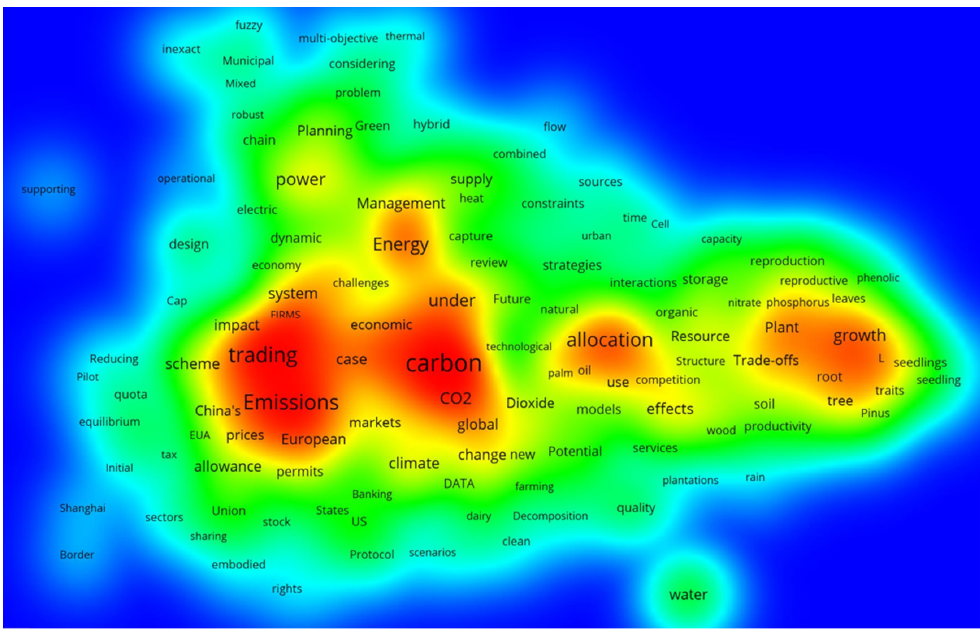
Figure 7. Words that appear more than ten times in the abstracts. As for the power sector, it frequently appears 1007 times (“power” and “electricity”), and scholars focus on the impacts of the ETS and allocation allowance plans on the power sector: evidence from the power sector, including effects on the electricity market (elec ‐ tricity demand, enterprises, and price), investment decisions, electrical technology (gen ‐ eration, supply system, and transmission), electricity planning, and so on.